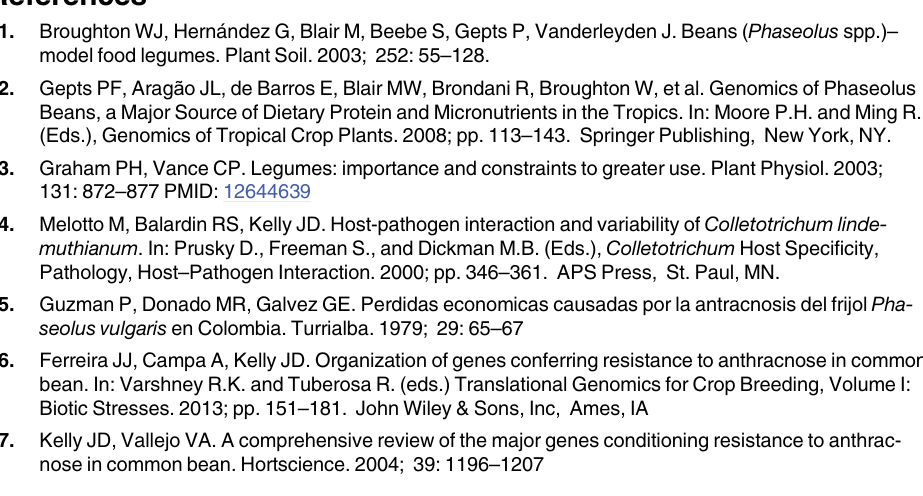
0 are most resistant, 5 are most susceptible. Cells in which an ‘ h ’ is listed is indication of a het- erogeneous mixture. Further details on the origin of the lines in the ADP can be found in the literature [27]. S2 Table. Twenty-eight lines within the 226 accessions from the Andean Diversity Panel with resistance to six or more of the eight races of anthracnose included in the study. a Di- sease scores are mean of six plants, 0 are most resistant, 5 are most susceptible [30]. S3 Table. The gene pool and prevalence of anthracnose resistance to eight races of Colleto- trichum lindemuthianum within the 226 bean lines from the Andean Diversity Panel. a A, Andean, MA, Mesoamerican or Mx Mixed gene pool designation of the race is based on level of virulence on host differentials from either gene pool; Further information on races is pro- vided in the literature [6, 28]. S4 Table. Thirteen SNP markers, location and physical position on chromosome Pv01 used to identify major QTL for resistance to anthracnose race 73 in Jaguar x Puebla 152 black bean RIL population. (cid:2)(cid:2) significant at Pr(F) = 0.01%; further information on SNP can be found in literature